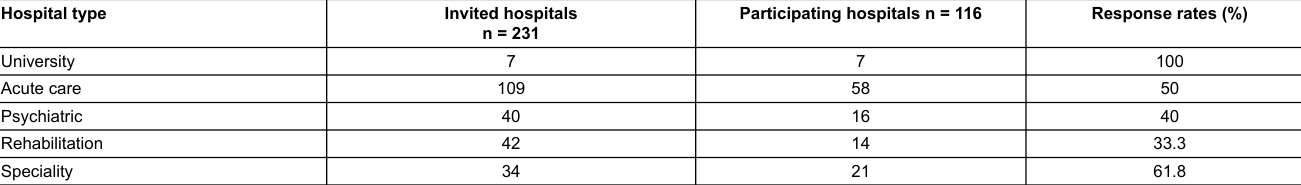
Table 2: Invited and participating hospitals * .